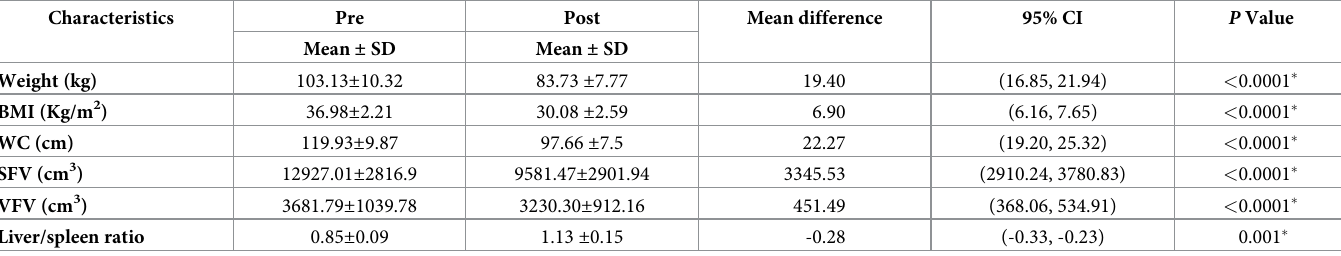
Table 3. Weight, body mass index, waist circumference, subcutaneous fat volume, visceral fat volume, and Liver/spleen ratio pre- and post-intervention for study group. Characteristics